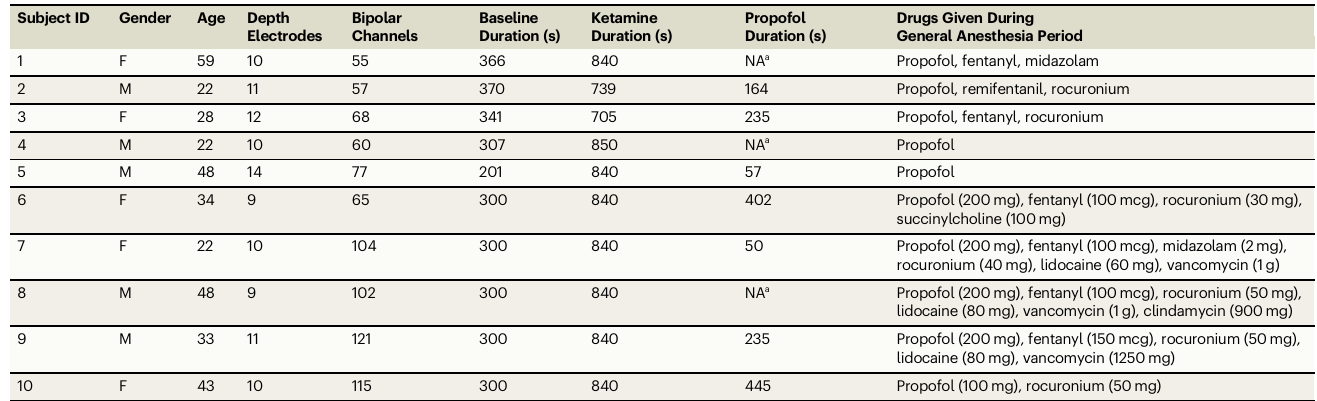
Supplementary Table 1. The responses on the questionnaire are con- sistent with a dissociative state induced by subanesthetic